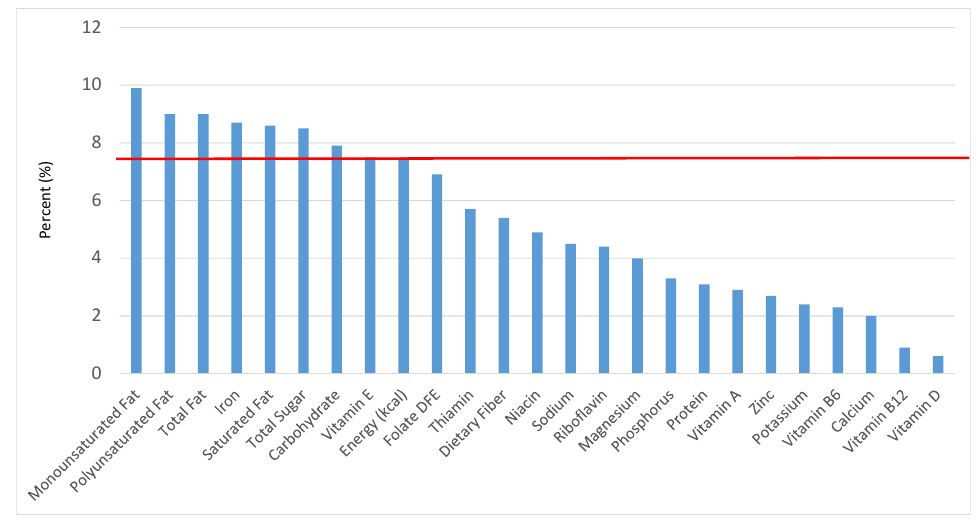
Figure 28. Sweet bakery products as sources of energy and nutrients for children 4–8 years old ( N = 1917, daily intake data): DFE = Dietary Folate Equivalents; solid red line represents percentage of energy (kcal) provided in the diet relative to nutrients—nutrients above the red line show the grain food’s contribution to nutrient density.